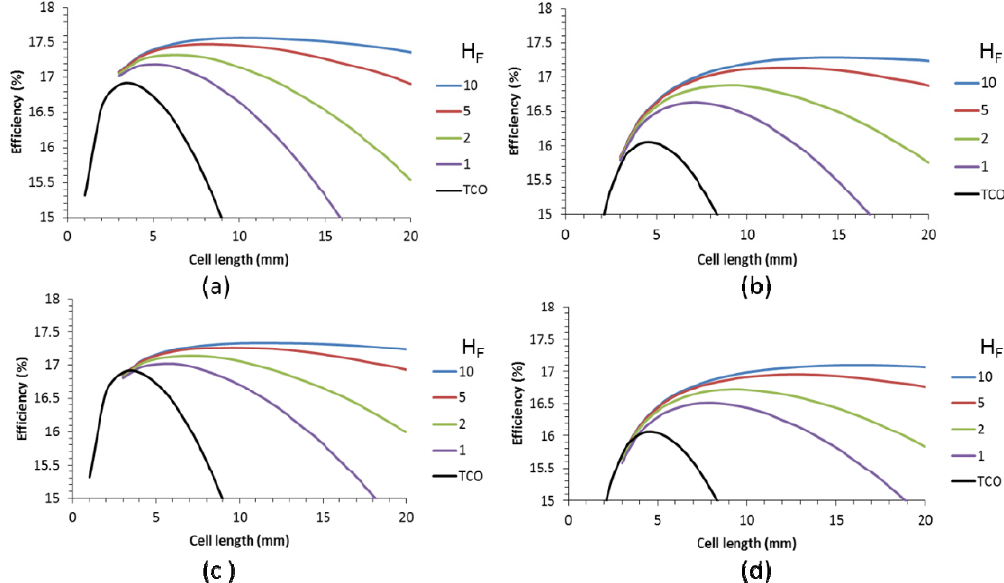
Figure 7. Efficiency of solar panels as a function of the individual cell length for different grid finger heights (H F , in μ m) for a scribe width of 150 μ m ( a , c ) and 350 μ m ( b , d ). The finger width is 60 μ m ( a , b ) and 100 μ m ( c , d ). The data are based on a Voc of 0.7 V. Using a wider finger width than 20 μ m decreases the efficiency benefit over the TCO only case.